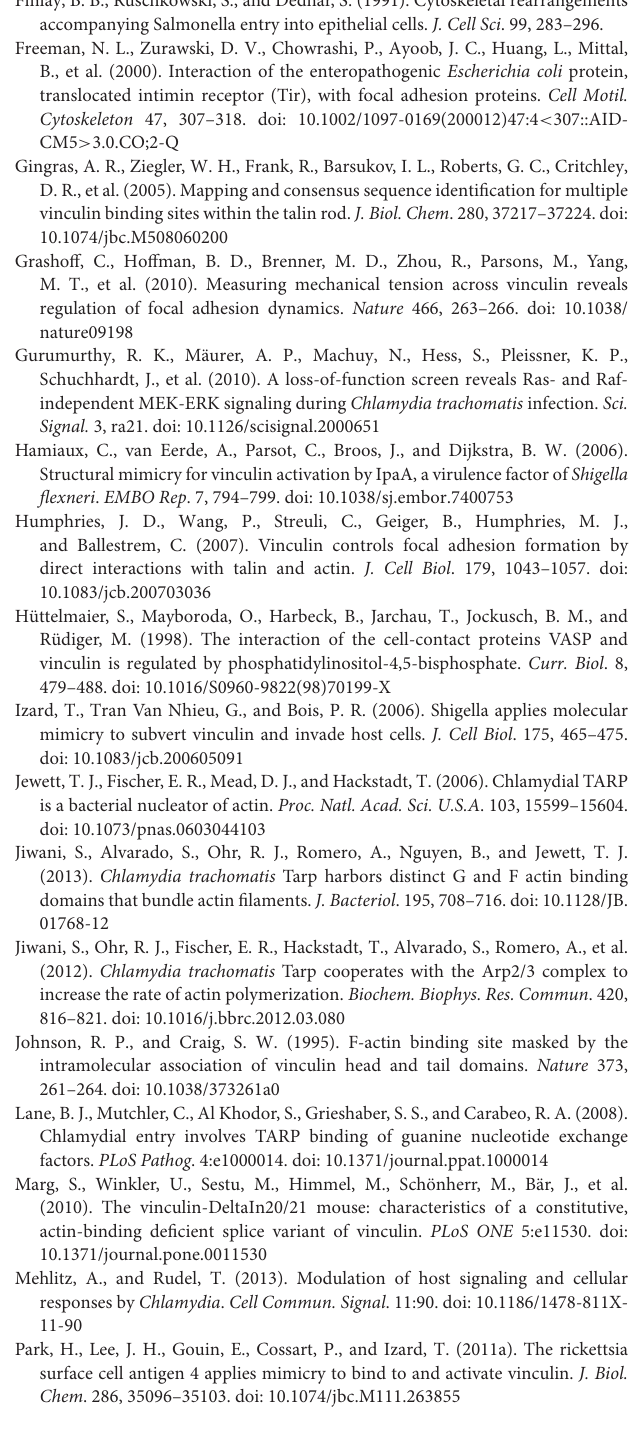
code and are colored based on their chemical properties. Hydrophobic (I, L, V, M: black; A, G, P: Green), hydrophilic (S, T: yellow; Y: blue; N: pink), and charged (D, E: red; K, R, H: light blue). The lines indicate bonds between amino acids. The arrow indicates the direction of the calculated hydrophobic moment, which is quantitative measure of